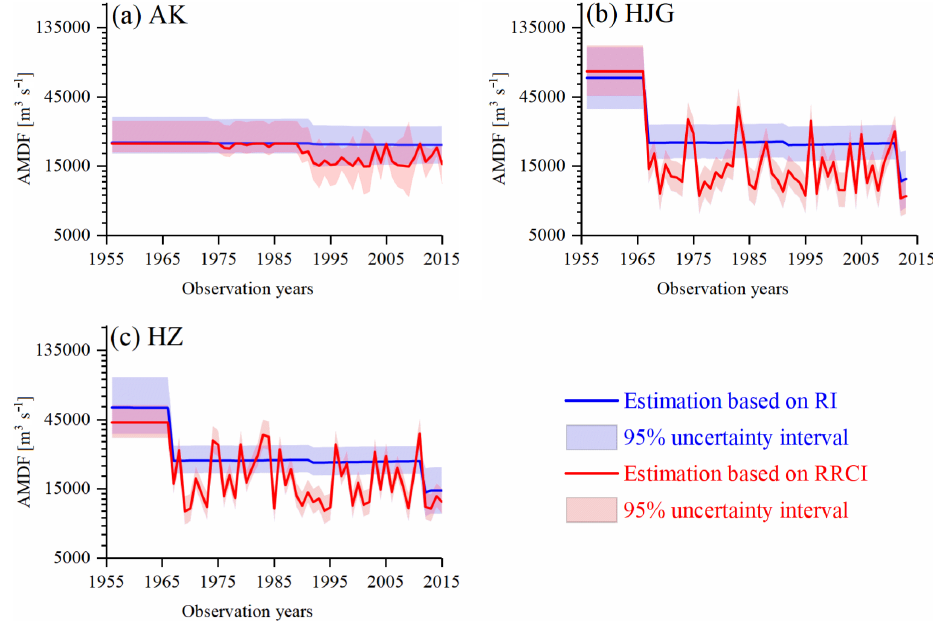
Figure 9. Statistical inference of the 100-year return levels with a 95% uncertainty interval using the optimal RI-dependent and the RRCI- dependent distributions: (a) WEI_S13 and WEI_S23 for the AK station, (b) GA_11 and GA_S21 for the HJG station, and (c) WEI_S11 and WEI_S21 for the HZ station. In nonstationary case, the 95% credible interval in the t year is calculated by a set of the (99th) percentile estimations, which are obtained by the flood distribution functions determined by the values of both covariate in that year and posterior parameter